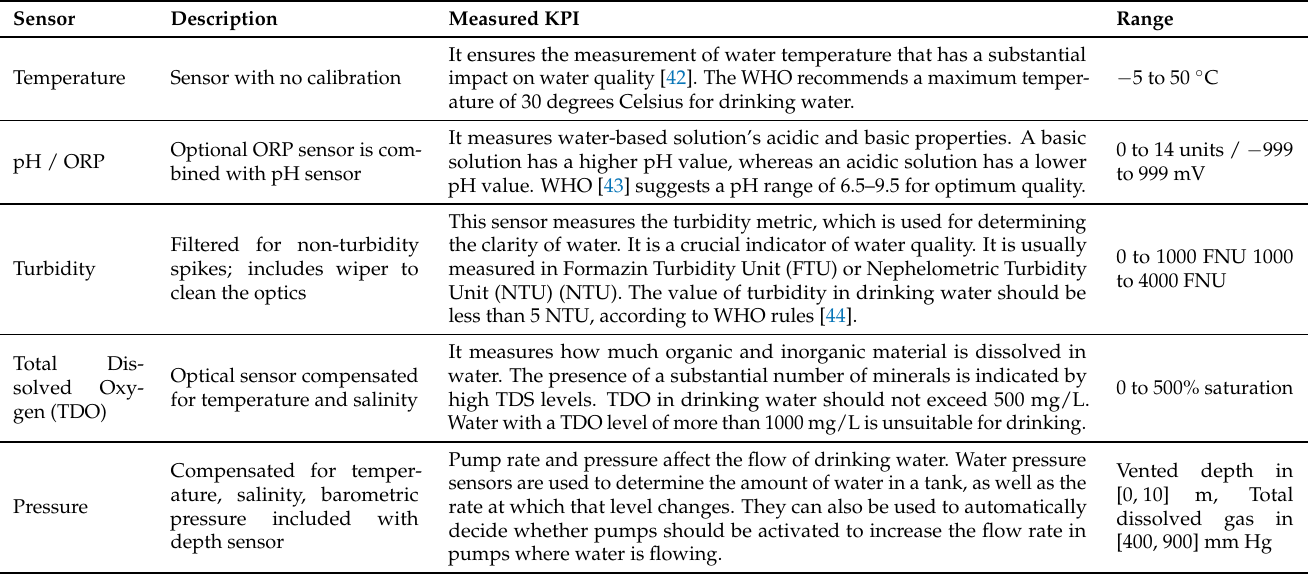
Table 1. Examples of water quality